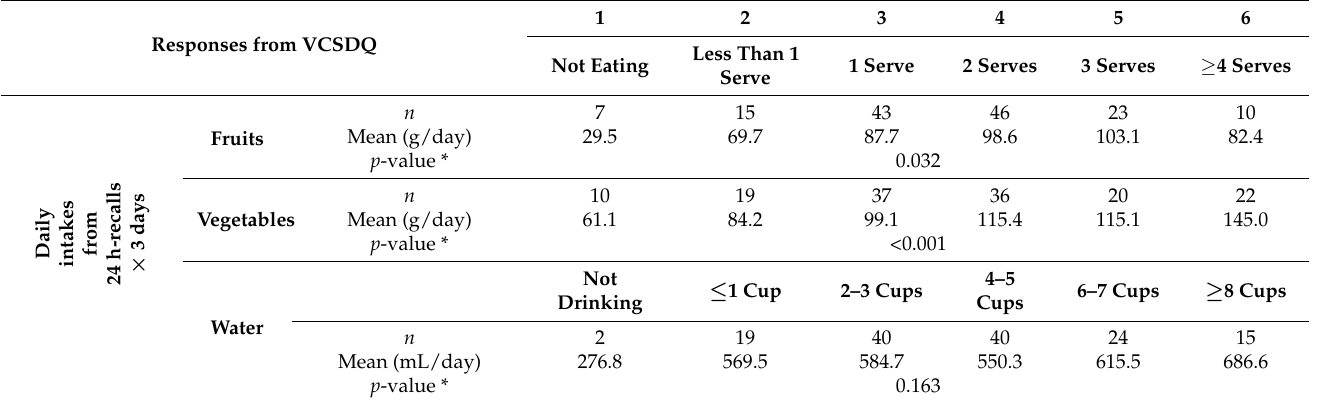
Table 7. The correlation between daily intakes of fruits, vegetables, and water from the 24 h recalls with the number of serves of fruits/vegetables and cups of water from the VCSDQ ( n = 144). 1